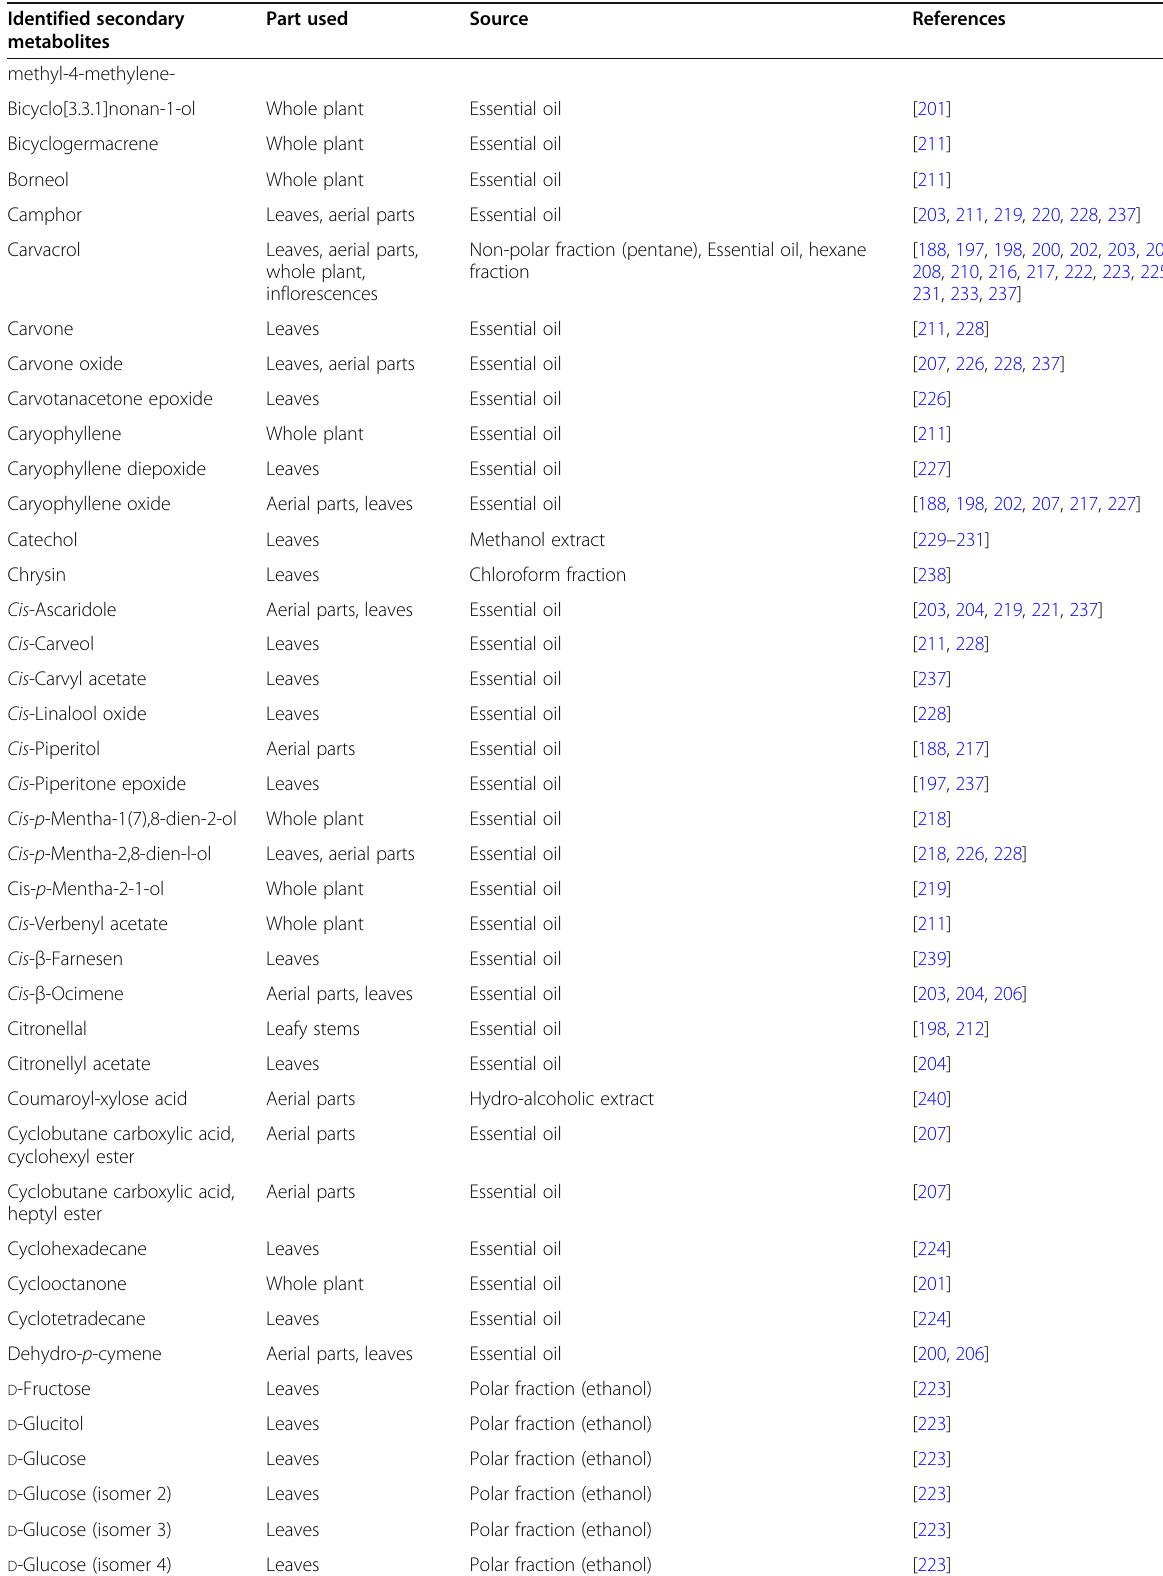
Table 3 Main secondary metabolites identified in C. ambrosioides